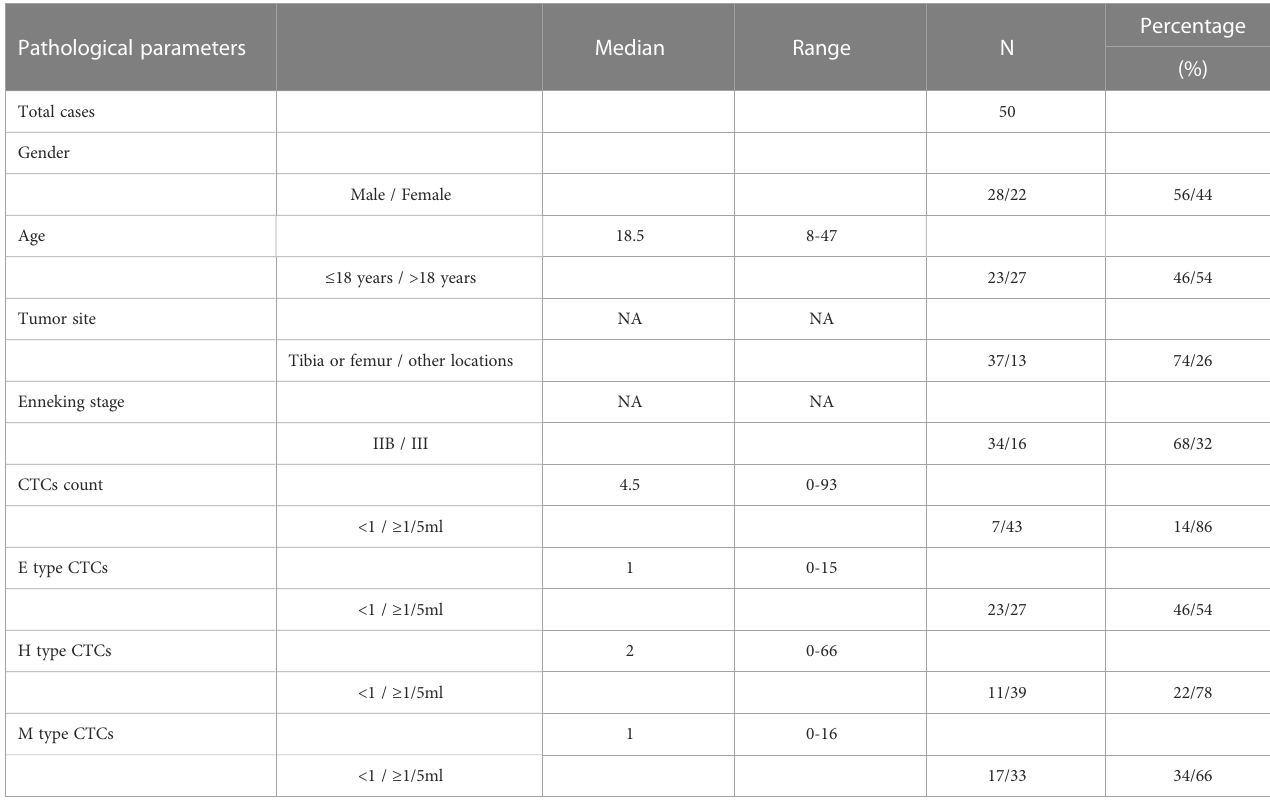
TABLE 2 Clinical characteristics and CTCs test of the 50 osteosarcoma patients.